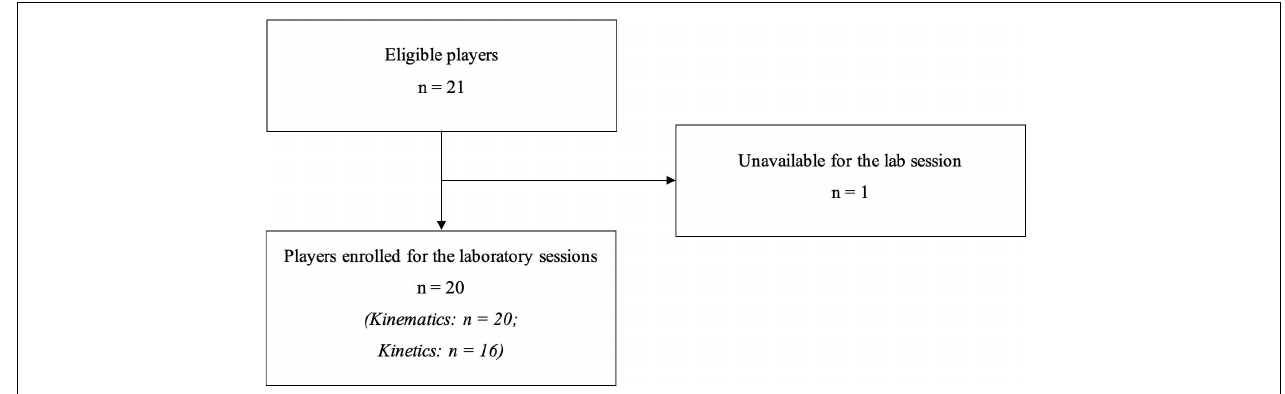
FIGURE 1 | Participants flow and availability.